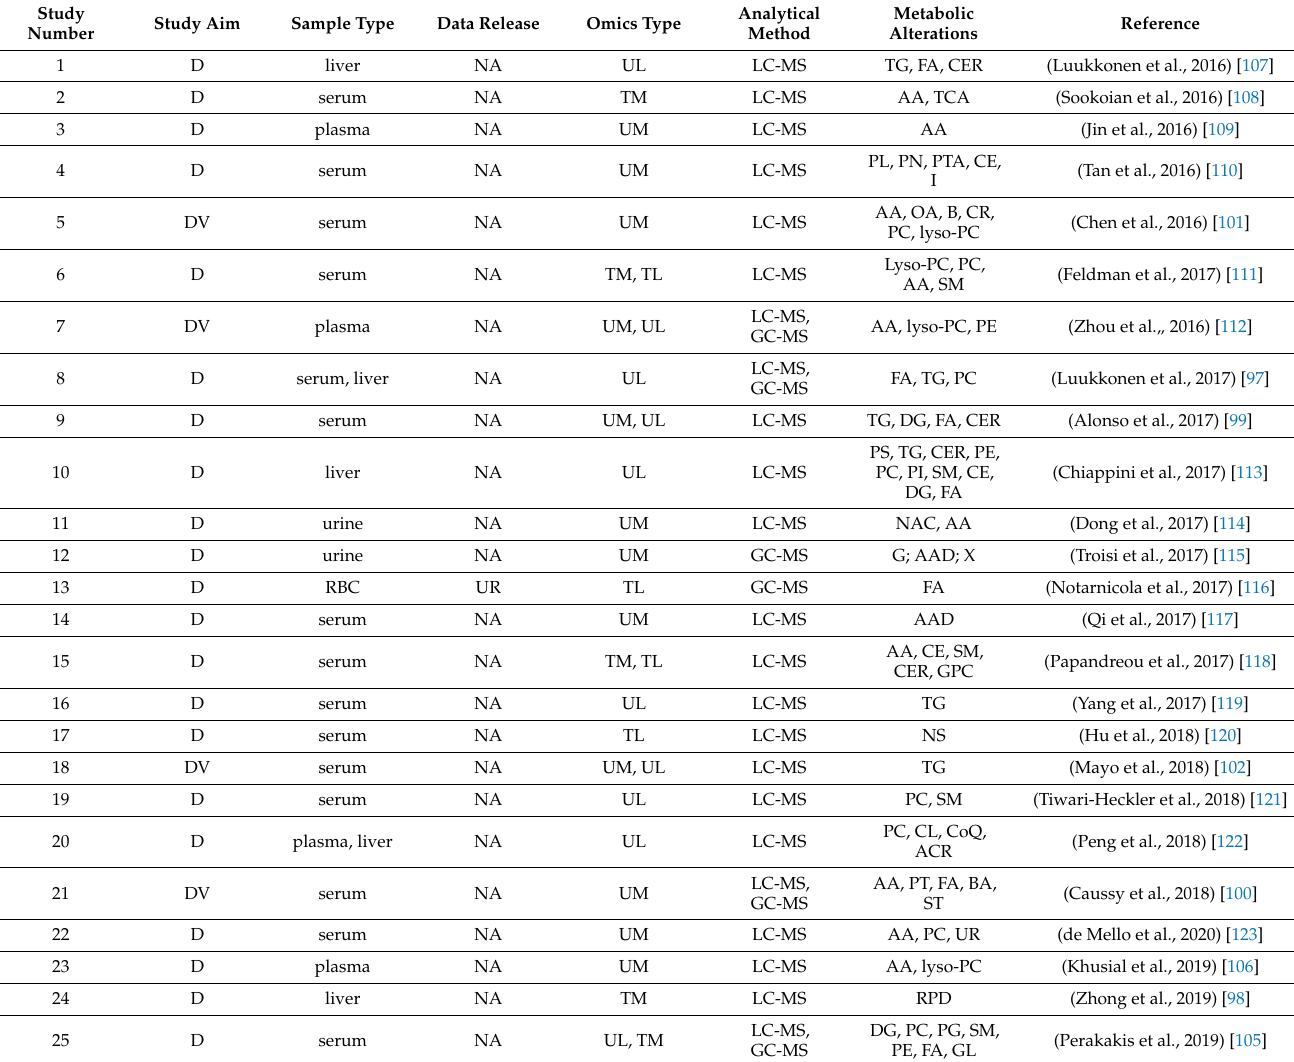
Table 2. Overview of MS-based metabolomics in NASH/NAFLD human